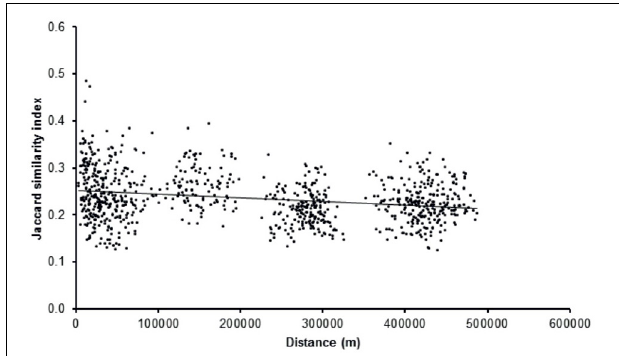
FIGURE 6 | Diversity (Jaccard similariy) plotted against distance for all stations ( R = 0.16, p < 0 . 01, 999 permutations).